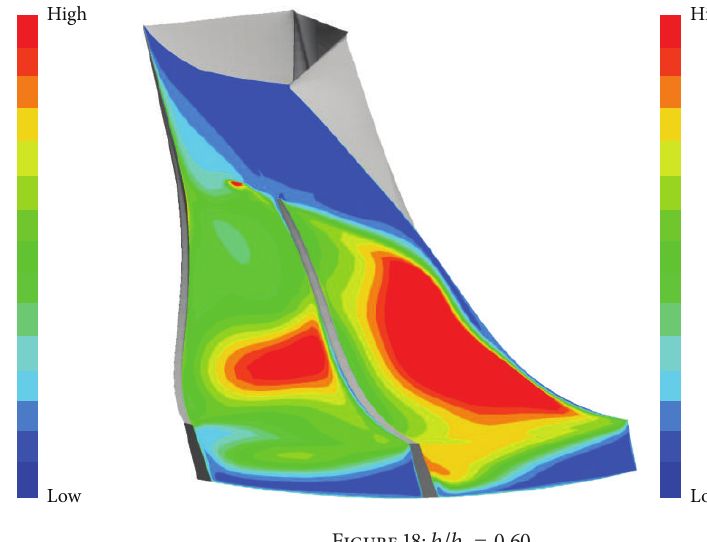
Figure 18: 𝑏/𝑏 2 = 0.60 .